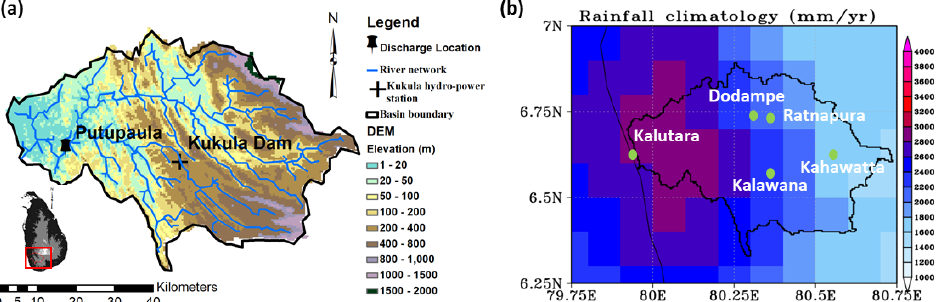
Figure 1. Locations of the study area and gauges: ( a ) the demarcation of the Kalu River basin, digital elevation model, and the river network and ( b ) annual GSMaP rainfall climatology (2001 – 2015) and the location of real-time rain gauges (green dots).